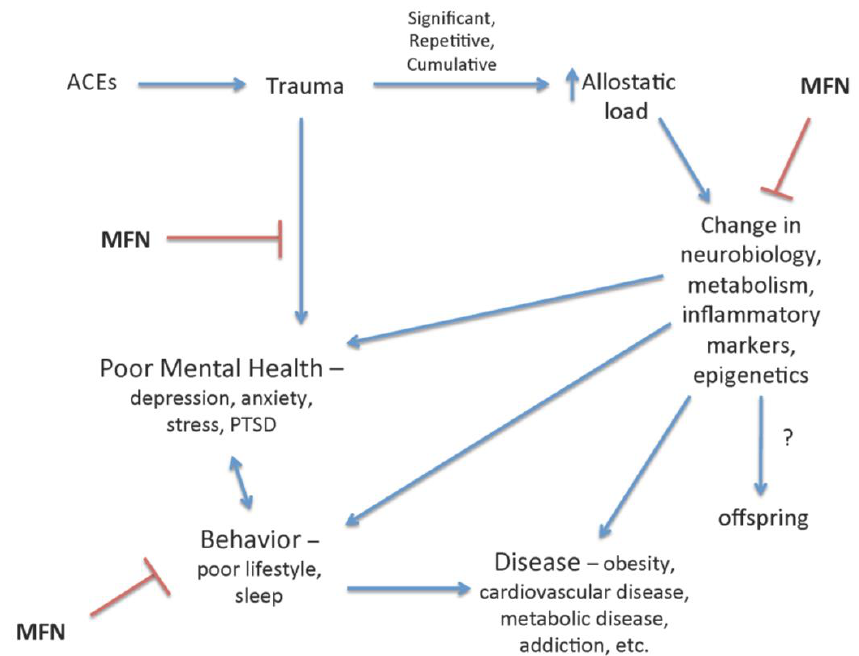
Figure 2. The negative impact of adverse childhood events (ACEs) and trauma in childhood